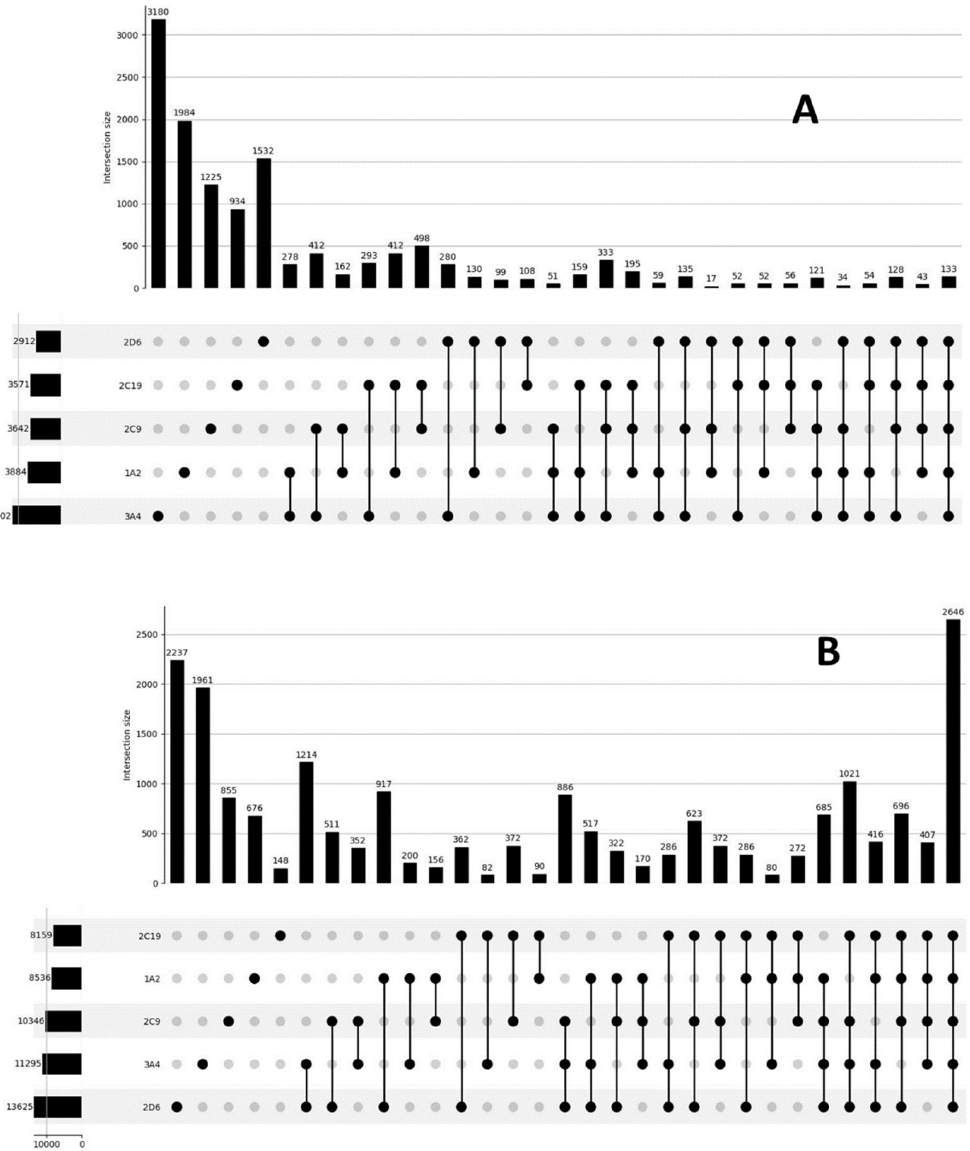
Figure 2. UpSet Plot showing how inhibitors (A) and noninhibitors (B) of different isoenzymes intersect.